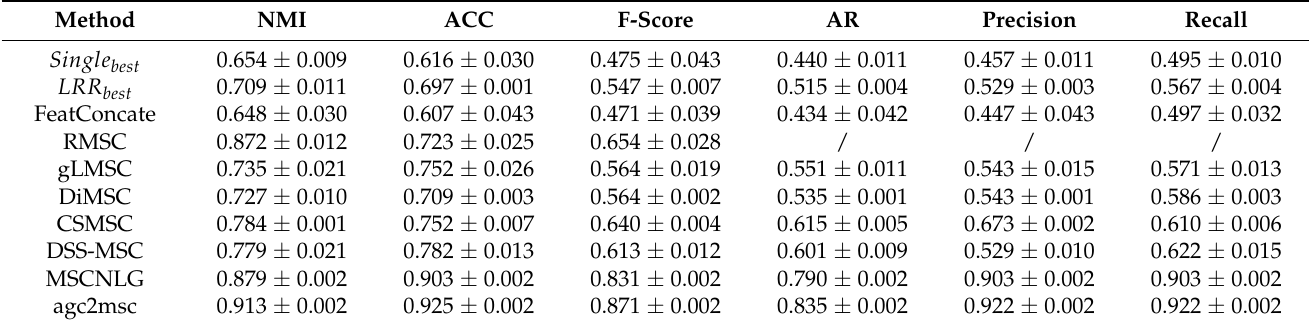
Table A3. Clustering results of the ten methods on